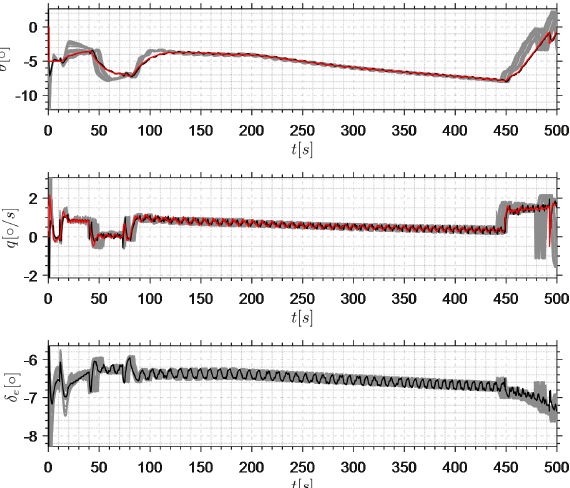
Figure 25. Perturbation simulation of pitch channel during the gliding phase.